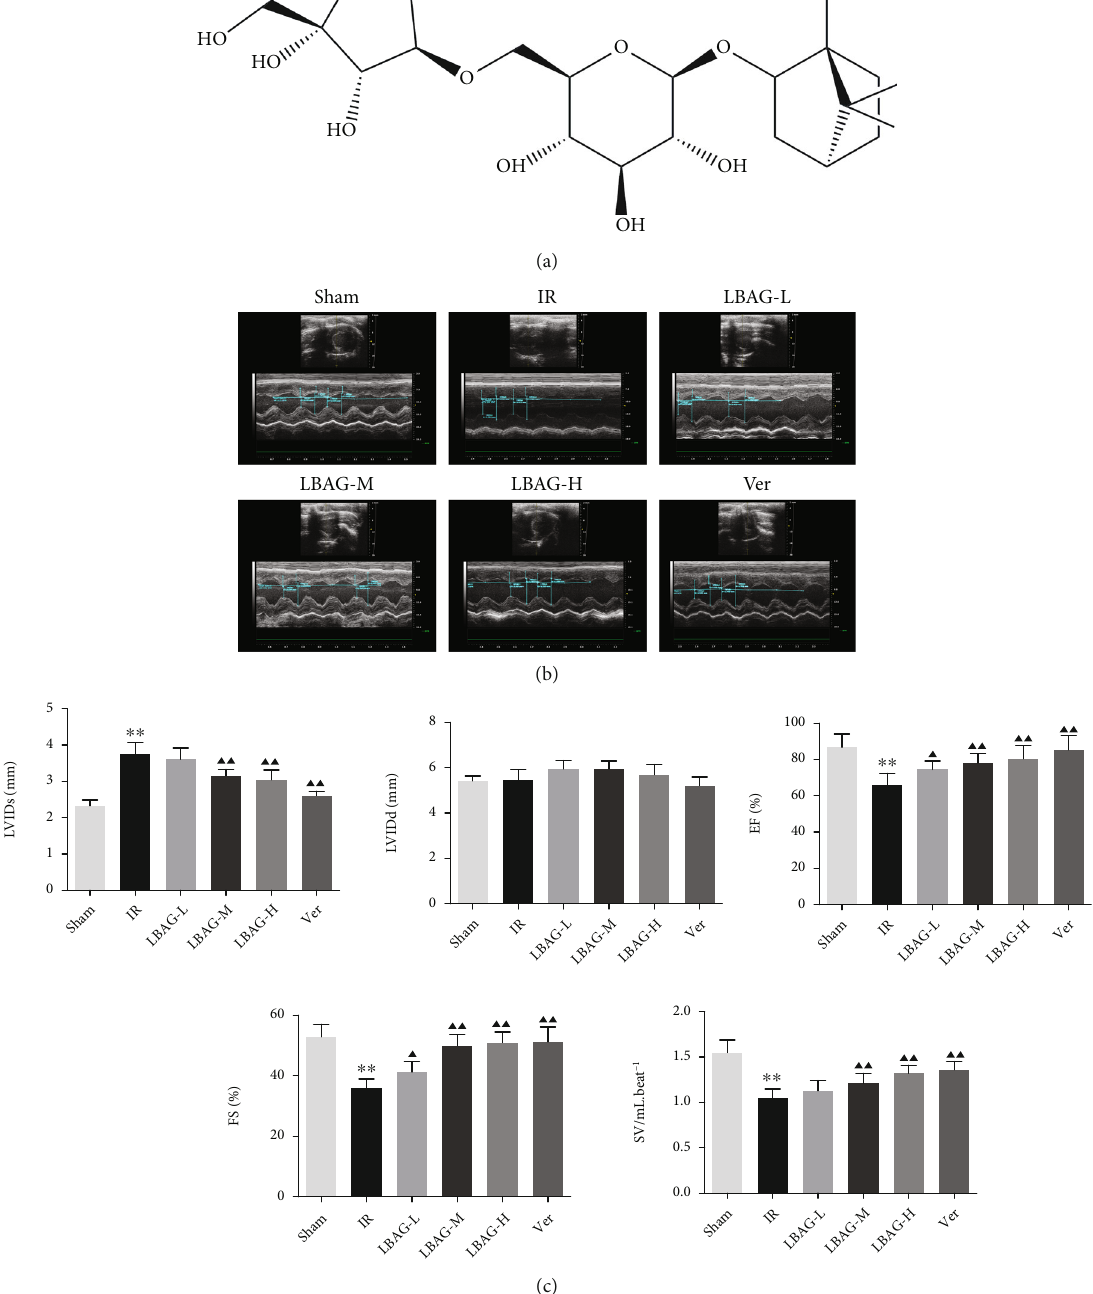
Figure 1: E ff ect of LBAG on cardiac function in rats. (a) Molecular structure of LBAG. (b) Representative M-mode images of echocardiography were performed 24h after I/R injury in each group. (c) Statistical analysis of LVIDs, LVIDd, EF, FS, and SV. ∗ P < 0 : 05 and ∗∗ P < 0 : 01 vs. sham group. ▲ P < 0 : 05 and ▲▲ P < 0 : 01 vs. IR